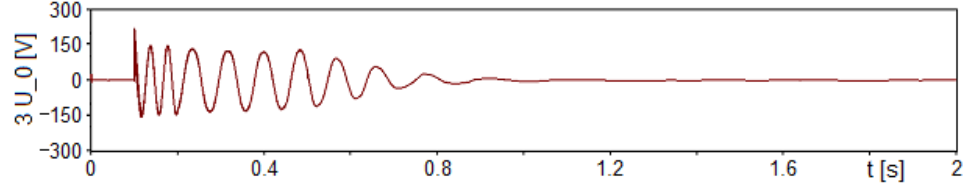
Figure 13. The voltage waveform in the open delta circuit, taking into account the damping resistor R_OTD = 25 Ω in the additional winding system.